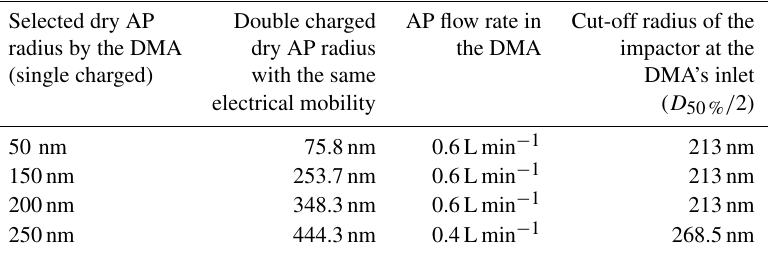
Table 1. AP selection parameters.